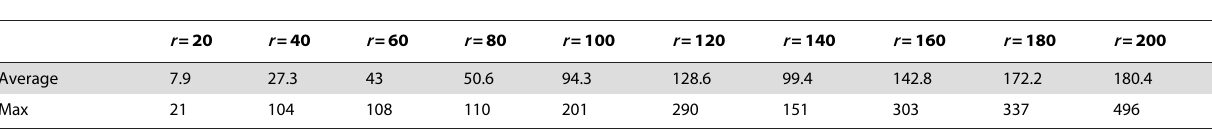
Table 3. Number of generations to find the best